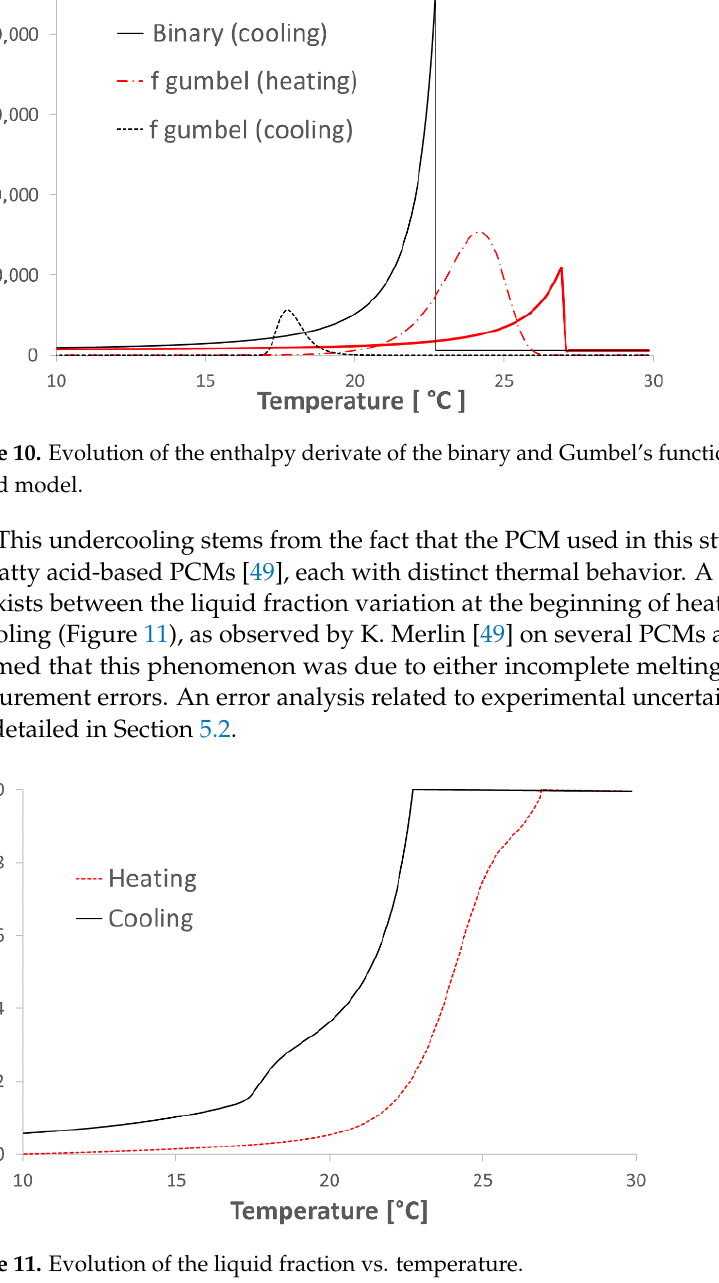
Figure 9. Evolution of the enthalpy derivative vs. temperature (hybrid model).